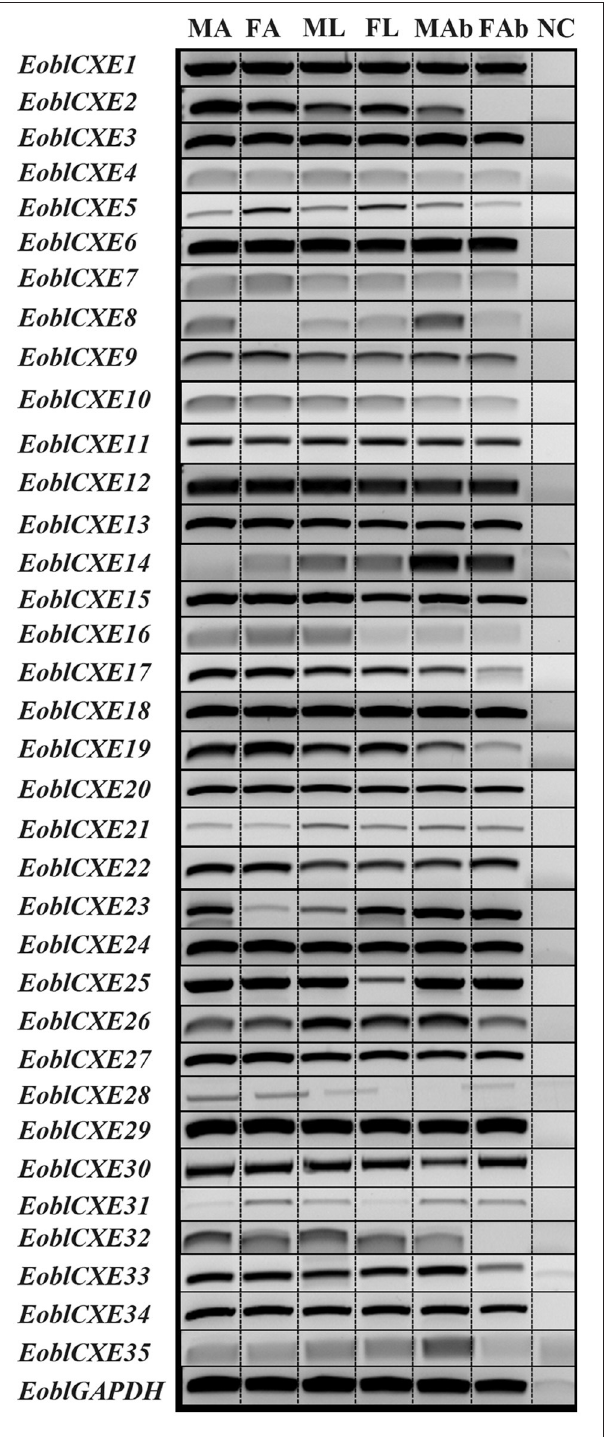
FIGURE 2 | Tissue-related expression patterns of EoblCXE genes, as revealed via RT-PCR. The EoblGAPDH gene was used as a positive control, and NC (no cDNA template) was used as a negative control. MA, male antennae; FA, female antennae; ML, male legs; FL, female legs; MAB, male abdomen; FAB, female abdomen. The original image of this is shown in Figure S2